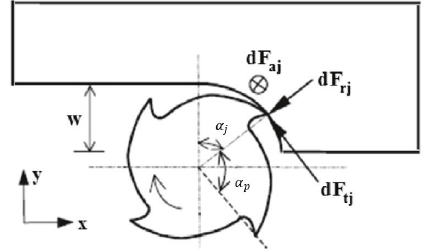
Figure 1. Illustration of milling process dynamics